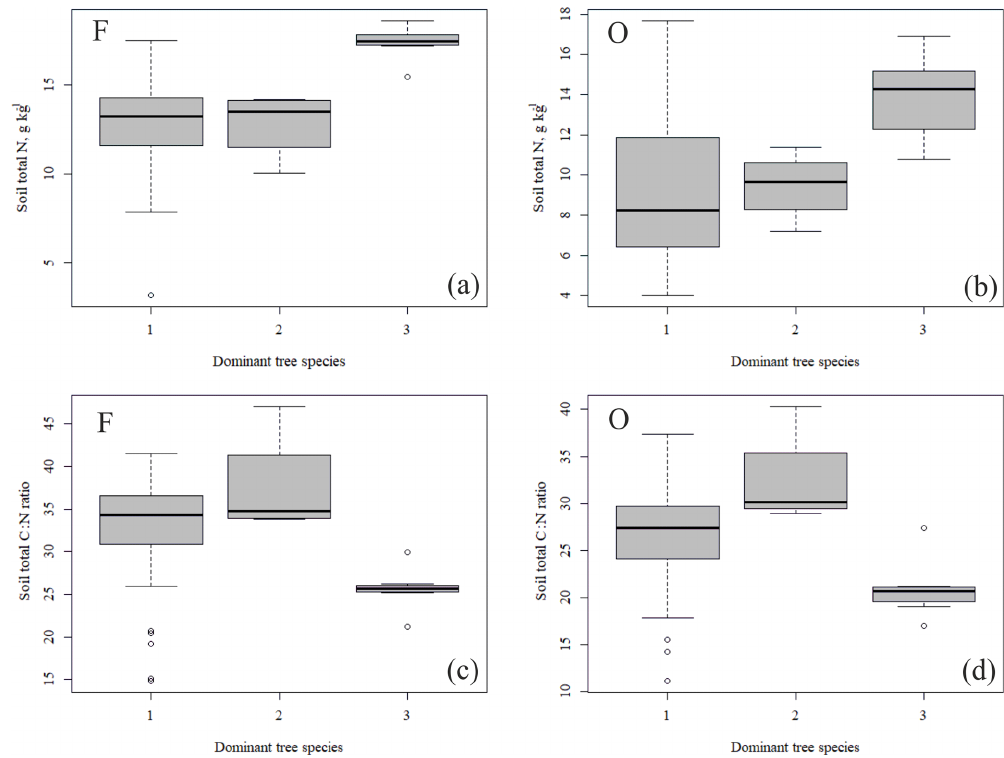
Figure 4. Soil total N content (a, b) and soil C : N ratio (c, d) of the research plots (based on dominant tree species) in soil horizons F and O (species 1 = pine; species 2 = spruce; and species 3 = birch. Table 2. Average foliar element contents (gkg − 1 ) of the three major nutrients and C, and the relationships of C : N and N : P with